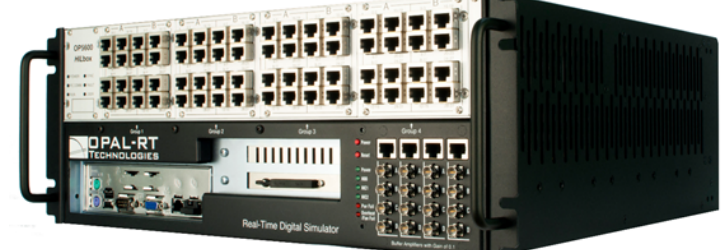
Figure 16. Real time simulator